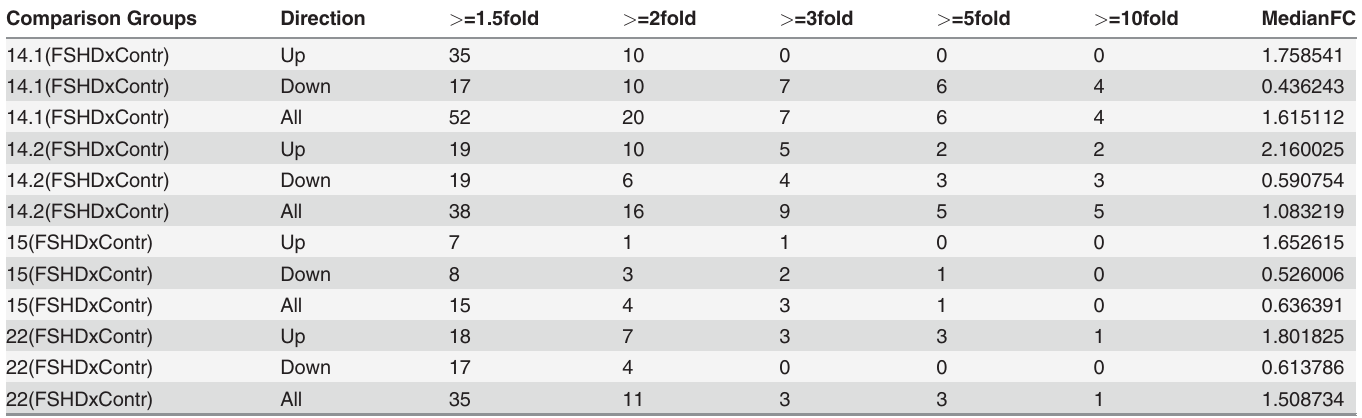
Table 2. Summary of differentially expressed